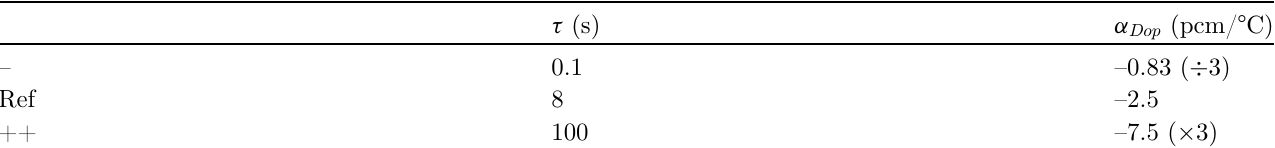
Table 5. Sensitivity study parameters and modi fi cation range.